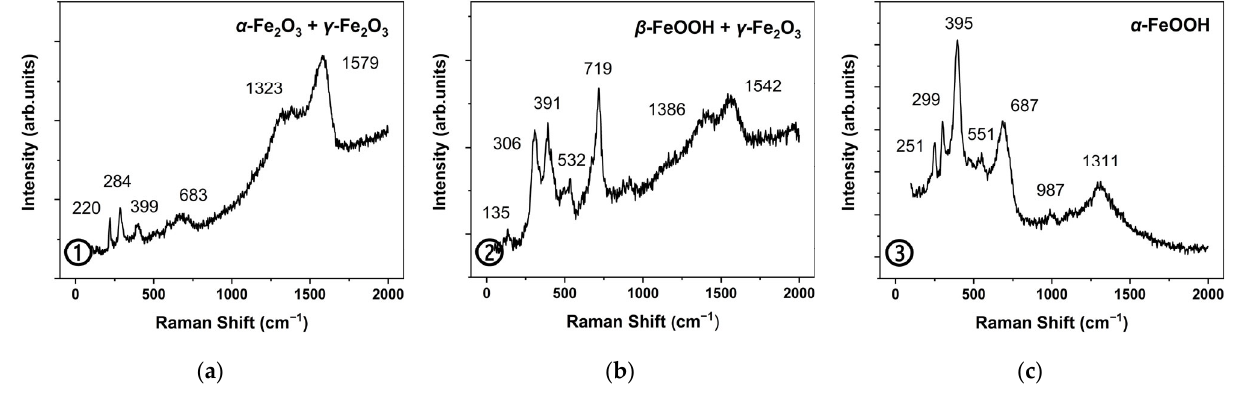
Figure 5. Micro ‐ Raman diagrams of original rust area A. Testing points 1–3 ( a – c ) in Figure 3a.